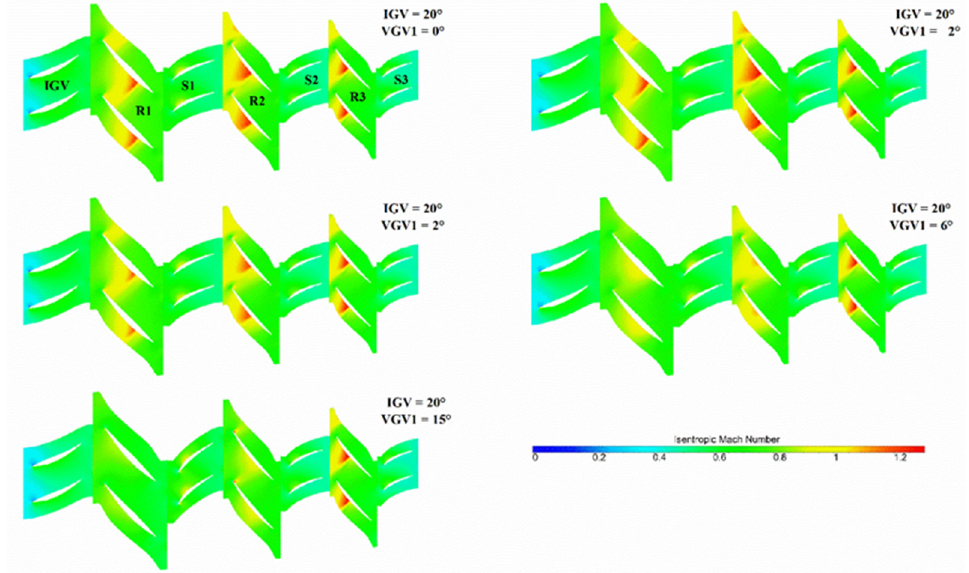
Figure 19. Isentropic Mach number distribution at 50% span (VGV1 adjustment).